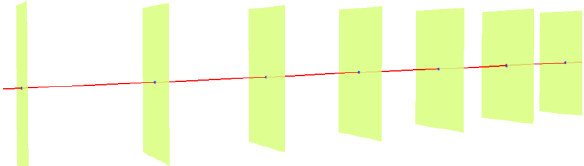
Figure 6. The tunnel axis (red line) is cut by perpendicular plans (green plans) crossing the axis in its vertices, segmenting it. The tunnel axis is cut in segments ( is the number of axis vertices). For each segment, comprehended between